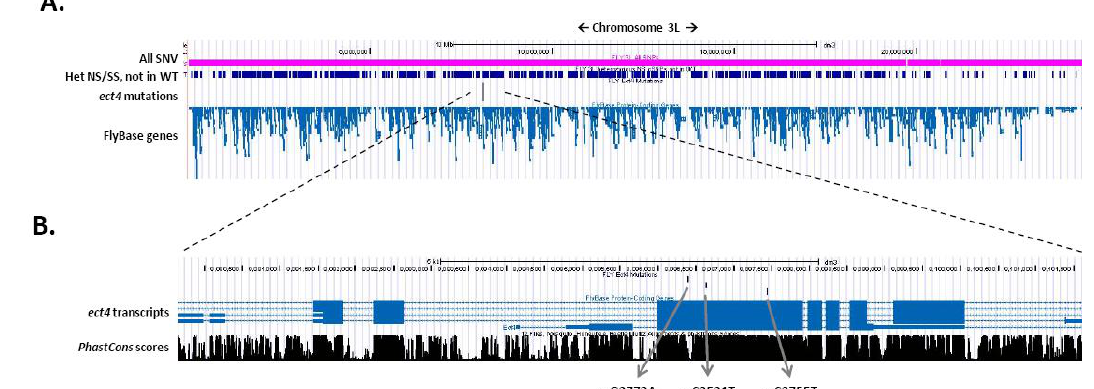
Figure 3 . Mutation density on chromosome 3L in screen (N = 3). (A) Screenshot of chromosome 3L with custom tracks in the UCSC genome browser. The pink line displays all SNVs on chromosome 3L that were detected in this screen. The navy line displays all heterozygous non-synonymous and splice-site SNVs on chromosome 3L not present in the wild-type fly. (B) Screen shot of ect4/dSarm with custom track displaying the location and conservation of the three ect4